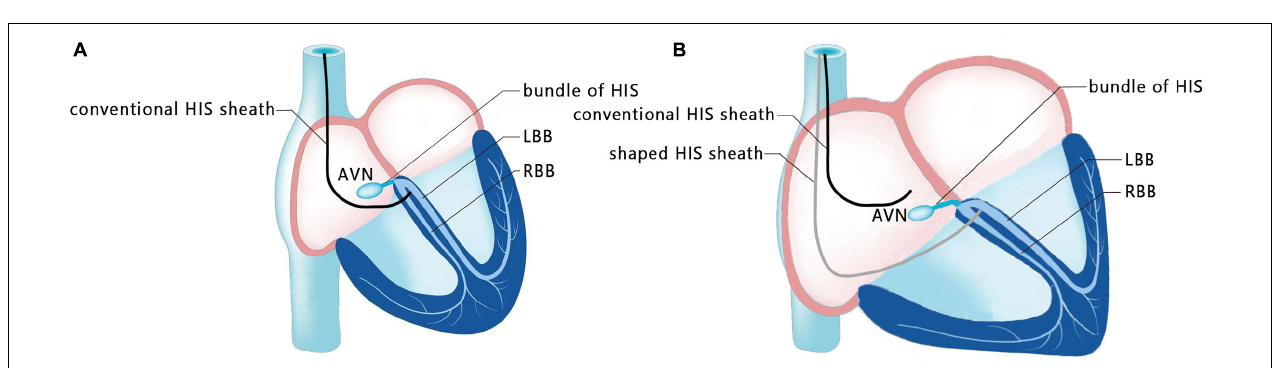
FIGURE 3 | Intracardiac electrograms. (a) There was no atrial action potential (red arrow) in RA. (b) Ventricular pacing at 5.0 V/0.5 ms output, and Sti-LVAT was 68 ms. (c) Ventricular pacing at 1.0 V/0.5 ms output, and Sti-LVAT was 68 ms.